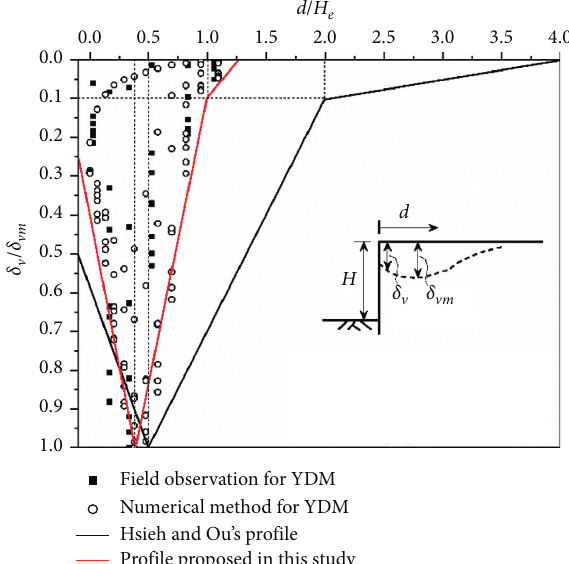
Figure 8: The surface settlement profile for YDM project and Hsieh